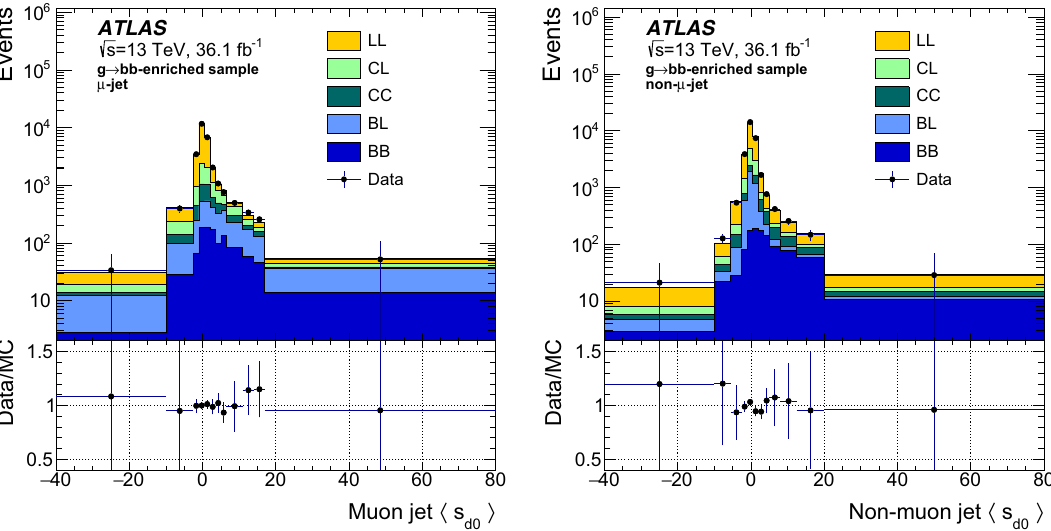
(cid:4) (cid:5) s d , distributions of the muon (left) and non-muon jet (right) in the (100–200) GeV bin of the 0